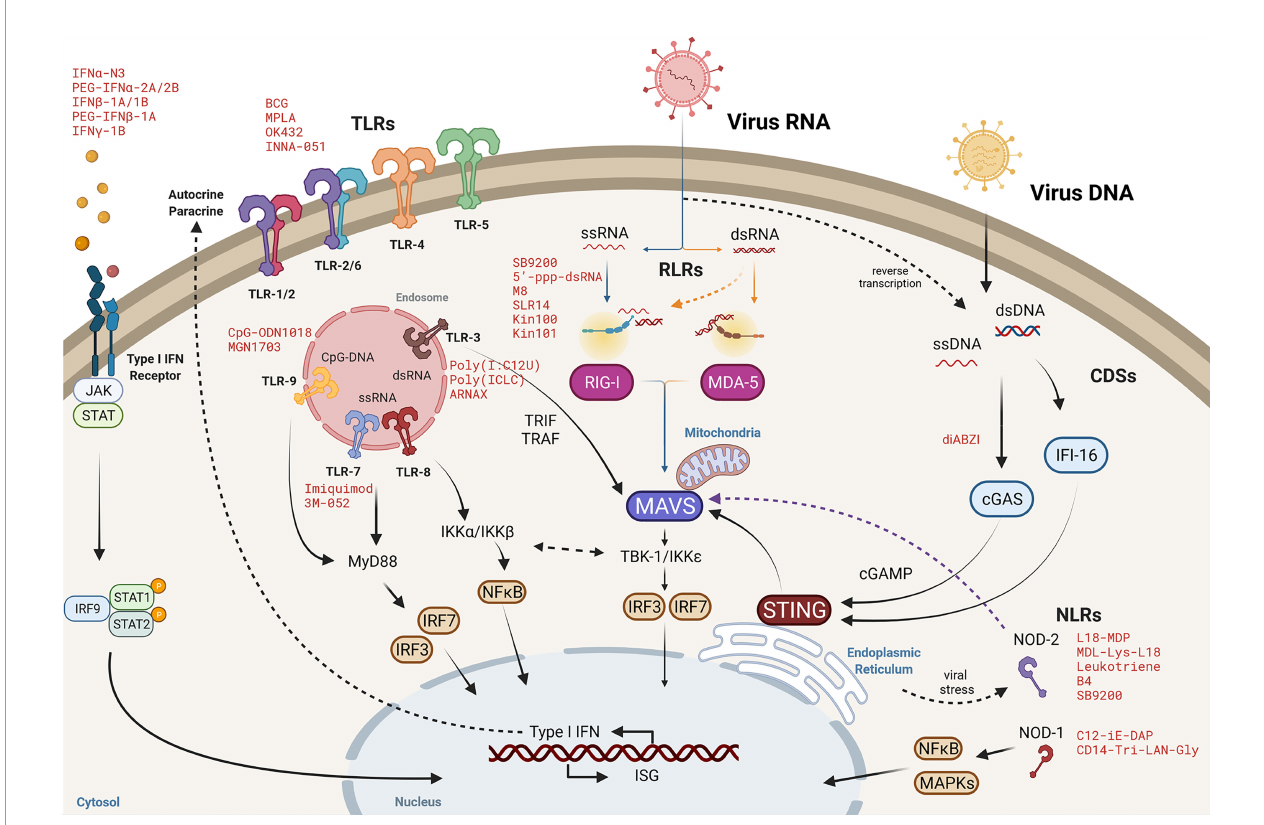
FIGURE 2 | Cytosolic viral RNA recognition by pattern recognition receptors. Molecular pathways of Toll-like receptors (TLRs), RIG-I-like receptors (RLRs), cytosolic DNA sensors (CDSs) and NOD-like receptors (NLRs) converge at different downstream signaling elements, such as at mitochondrial antiviral signaling protein (MAVS) or the TBK1/IKK ϵ axis to activate nuclear factor- k B (NF- k B) and interferon regulatory factor (IRF-3/IRF-7) and then, orchestrate a robust innate immune response by the expression of type I IFN and interferon stimulated genes (ISG) responses to clear viral infection. Representative agonists mimicking viral PAMPs or DAMPs are denoted in red as potential intervention approaches to promote an antiviral cellular